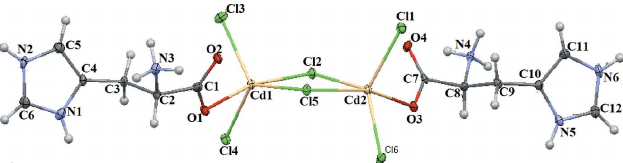
Figure 1 The asymmetric unit of (I), with displacement ellipsoids drawn at the 50% probability